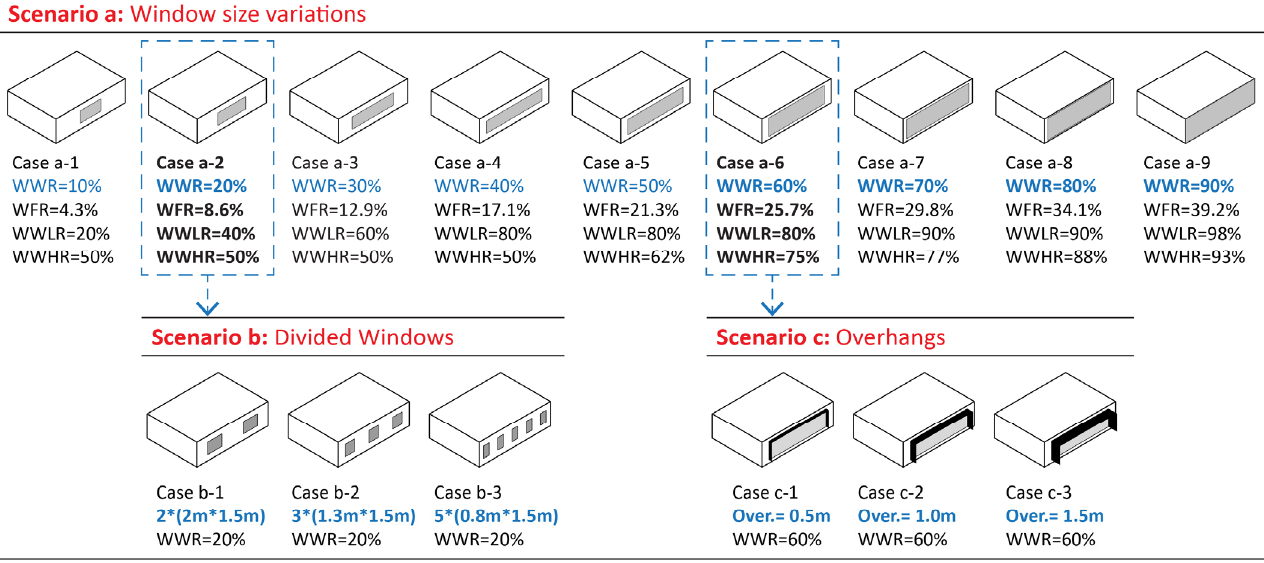
Figure 6. Architectural design scenarios as case studies for view access evaluations through the developed method and workflow.